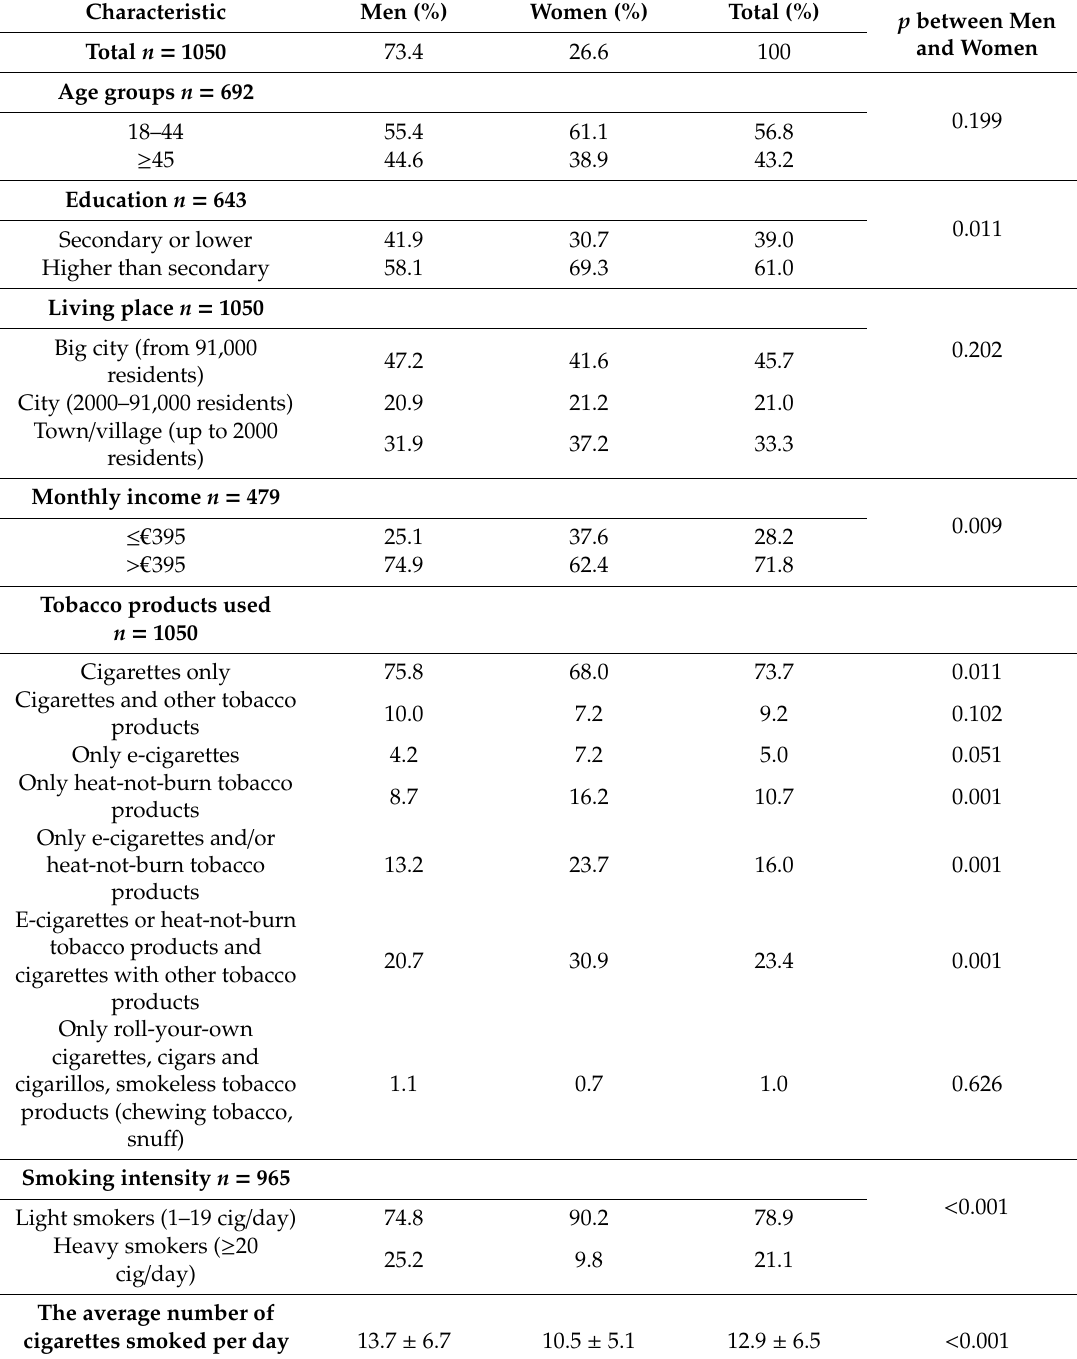
Table 1. Characteristics of the study